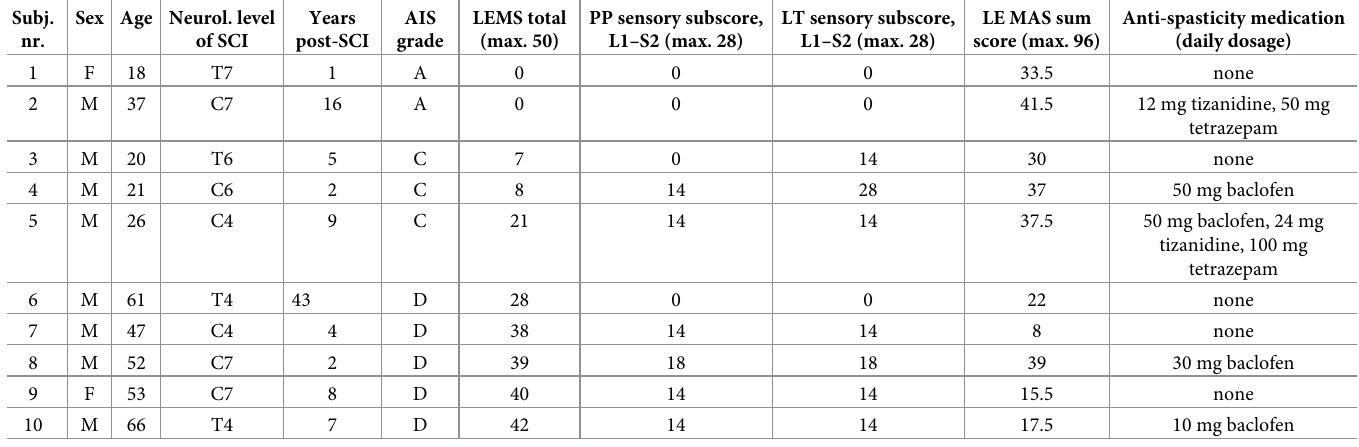
AIS, American Spinal Injury Association Impairment Scale; LEMS, lower extremity motor score; LT, light touch; LE MAS, lower extremity Modified Ashworth Scale; PP, pin prick